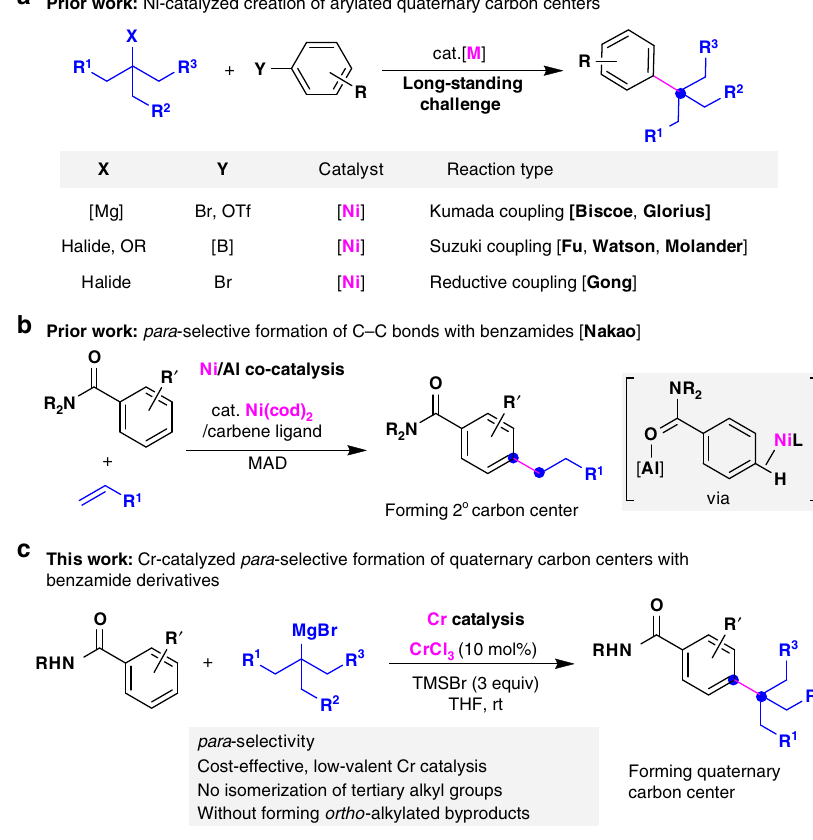
Fig. 1 Transition-metal-catalyzed formation of arylated quaternary carbon centers by alkylation. a Known examples of the formation of arylated quaternary carbon centers with nickel catalysis. b para -Selective alkylation of benzamide with nickel catalysis. c Cr-catalyzed para -alkylation of benzamides for the formation of arylated quaternary carbon centers